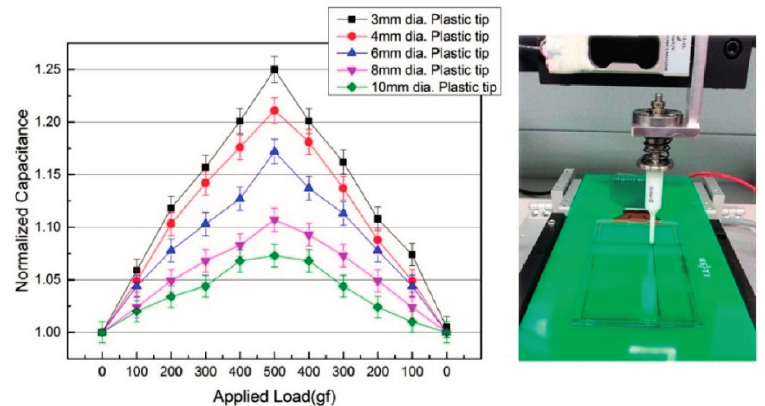
Figure 6. Graph of changes in capacitance value depending on the cross-sectional area of the tips used to apply the force to the center of the force sensing touchscreen; tips 3 mm to 10 mm in circular cross-sectional diameter were used to measure the effects of an applied force from 0 gf to 500 gf and in the reverse direction is also measured. ( Left ) The measured capacitance outputs according to circular cross-sectional diameter of the tip; ( Right ) The image of measuring output characteristics using the capacitance measurement system.